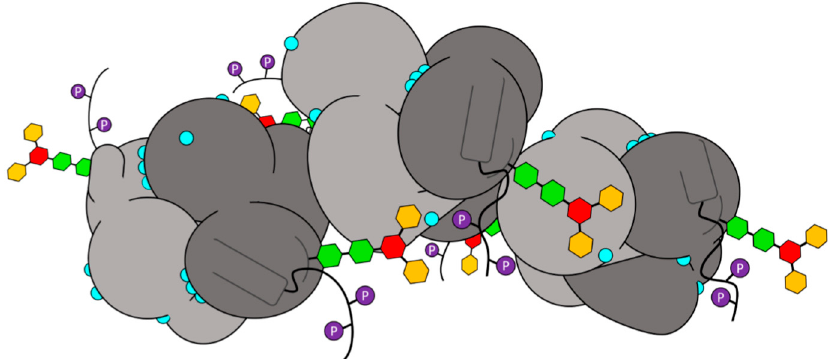
Figure 10. A representation of native human Casq2 based on the crystal structure of the native bovine Casq1 hexamer under high Ca 2+ concentration. The alternating light and dark gray bodies represent the monomers in the hexamer, with the spherical domains representing Domains I, II and III, the triangular portions representing their N-terminal arms and cylindrical portions representing α 12. Each glycan chain, GlcNAc 2 Man 3 in this case, is represented by two green hexagons for the two N -acetylglucosamines, a red hexagon for the β -mannose and yellow for the two branched α -mannoses. The glycosylation loop is a dark gray semi-circle. The thick black lines pointing away from the polymer represent residues 350 through 354 and a hypothetical C-terminal tail. The two possible C-terminal phosphoryls in human Casq1 are purple circles with a white letter “P”. Cyan spheres mark the location of crystallographic Ca 2+ ions that are visible from this perspective.